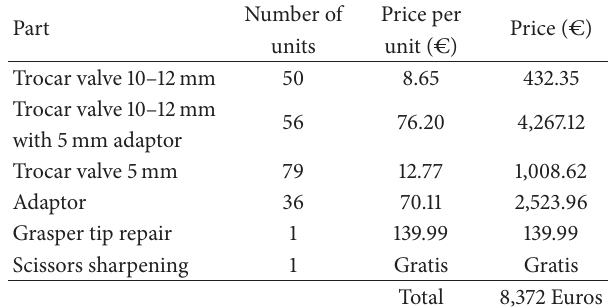
Table 2: Replacement and repair requirements (incl. VAT 23%).